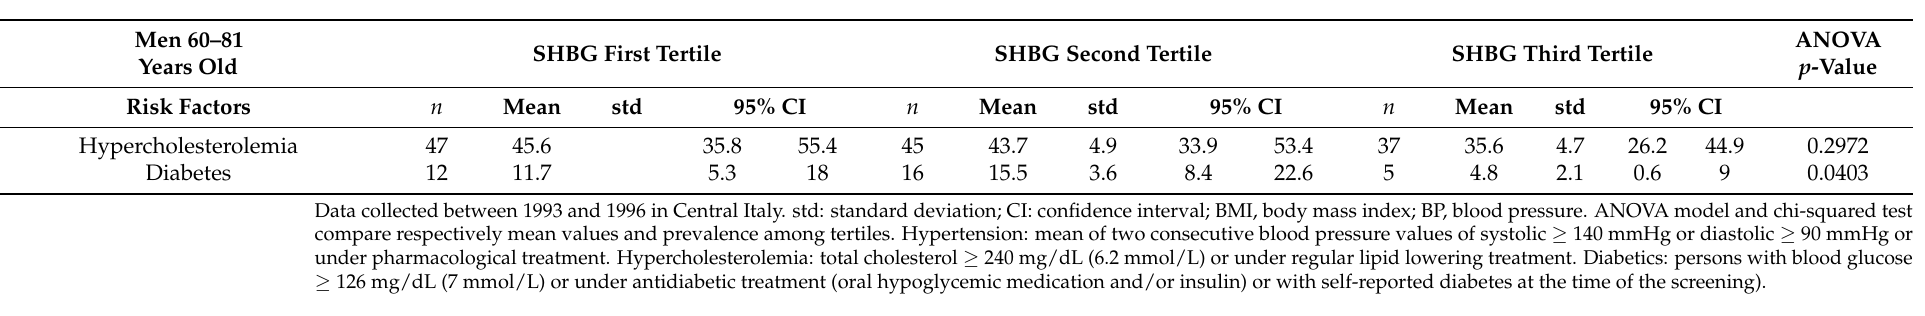
Table 4. Baseline characteristics by Sex Hormone-Binding Globulin (SHBG) tertiles and age groups. The Malattie Aterosclerotiche Istituto Superiore di Sanit à